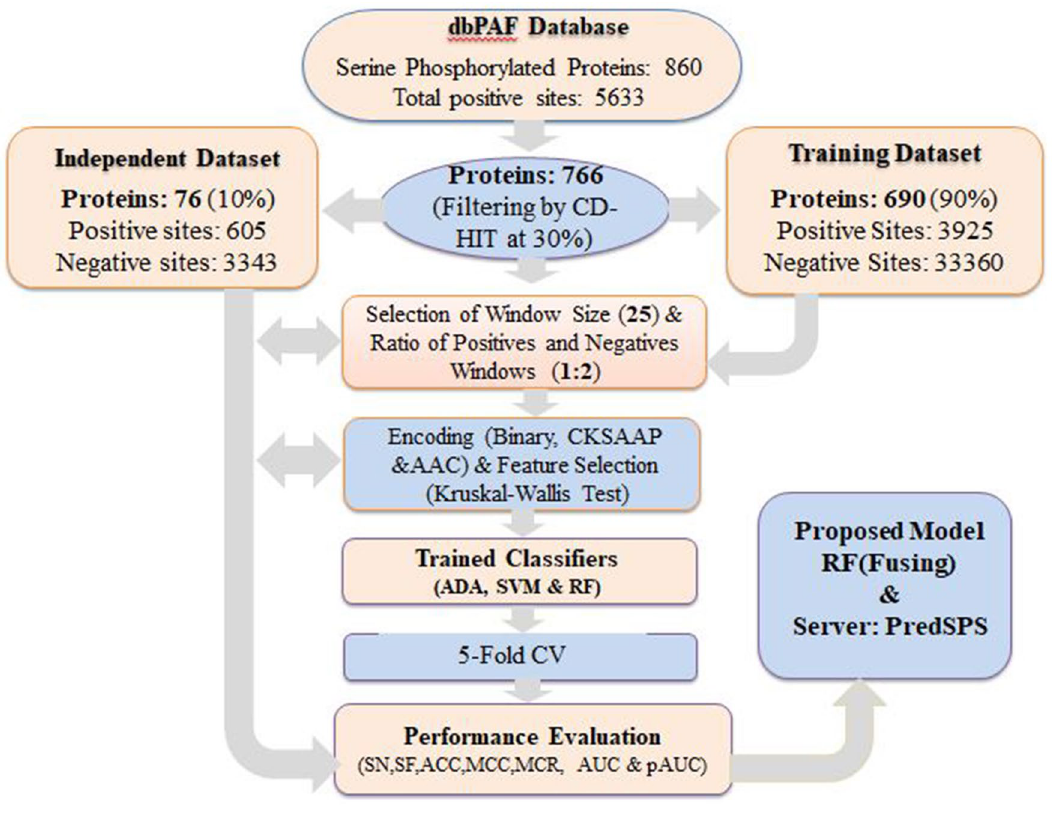
Figure 1. An overview of the proposed PredSPS